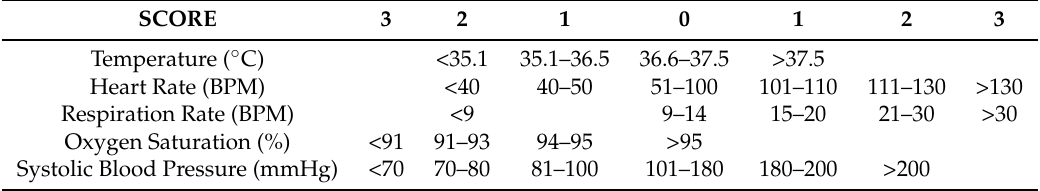
Systolic Blood Pressure